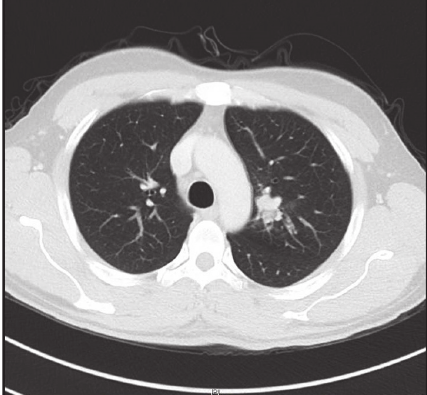
Figure 1: The Computed Tomography (CT) scan showed a lobulated round nodule in the left upper lobe adjacent to the bronchus measuring 1.8 × 1.6cm with an absence of significant lymph nodes. It is associated with a focal area of ground glass opacity and mild dilatation with mucus plugging.